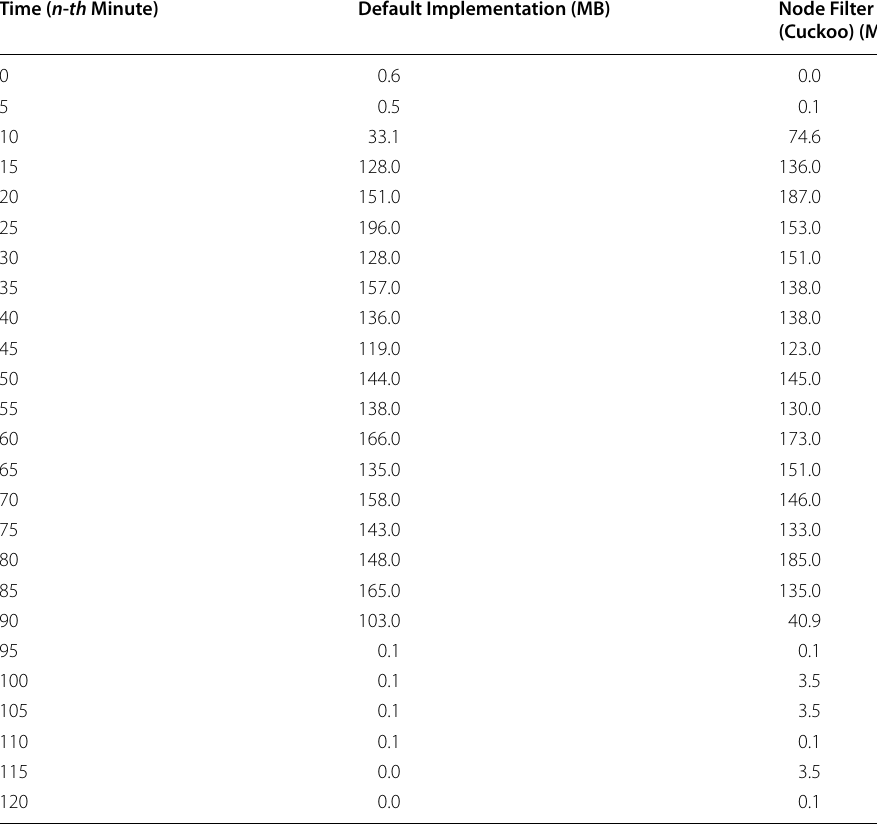
Table 12 Network bandwidth consumption (incoming) in megabytes by Node Filter Time ( n - th Minute) Default Implementation